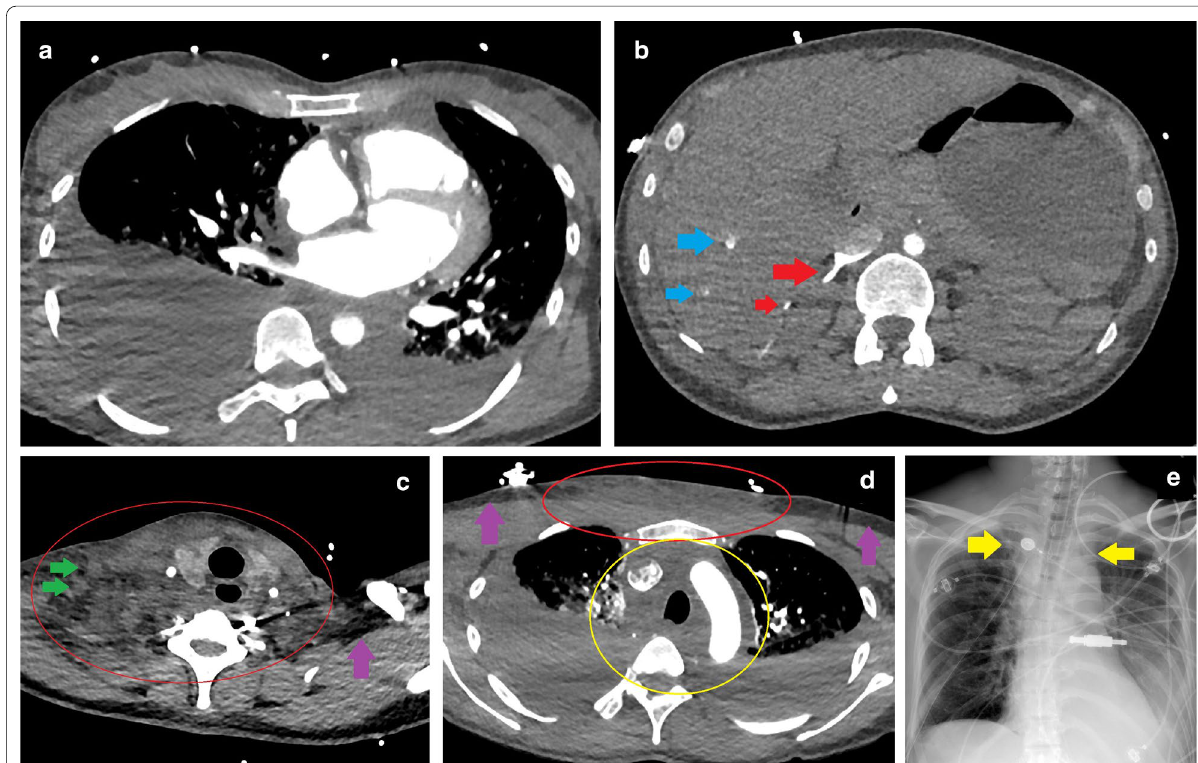
Fig. 18 Hindsight bias. A 40-year-old female patient with no known disease history presented at the ER with complaints of chest pain, dyspnea and confusion. As severe back and neck pain had been ongoing for two days, aortic dissection was suspected. Triple rule-out CT showed bilateral massive pleural effusion ( a , d ) and severe contrast reflux into the inferior vena cava, right renal vein (red arrows, b ), and peripheral branches of hepatic veins (blue arrows, b ). These findings were suggestive of hemodynamic compromise. Pleural effusions were drained, and a significant amount of pus was observed. The patient was accepted as septic, and proper treatment was started. Microbiological evaluation of the pleural fluid was consistent with Streptococcus pyogenes, an unexpected pathogen bacteria in pleural samples. After feedback from the microbiologist, an ecchymotic area spreading from the neck to the anterior chest wall was noticed. Soft tissue infection was suspected. When the CT was retrospectively re-evaluated, it was understood that increased densities in subcutaneous fat tissues of the neck and anterior chest wall (red circles c , d ) were not noticed by the on-call radiologist ( purple arrows c , d : normal fat tissue as a reference). Lymphadenopathies within the affected areas (green arrows, c ), and obliteration of upper mediastinal fat tissues (yellow circle, d ) were other considerable findings. Moreover, mediastinal widening suggesting mediastinitis was detected retrospectively on the chest X-ray obtained after thoracentesis (yellow arrows, e ). Subsequently, the clinical situation rapidly deteriorated, the patient became hypotensive and a sharp myoglobin increase suggesting myonecrosis was observed. Acute kidney failure, acute respiratory distress and profound thrombocytopenia developed. After evaluating the clinical, radiological and microbiological findings altogether, the diagnosis of “streptococcal toxic shock” was made. The patient died three days after the onset of the complaints and one day after ER admission. With the knowledge of S.pyogenes presence in the pleura, history of neck pain and location of the ecchymotic area, it seems impossible to have overlooked changes in soft tissues and the upper mediastinum during retrospective evaluation (hindsight